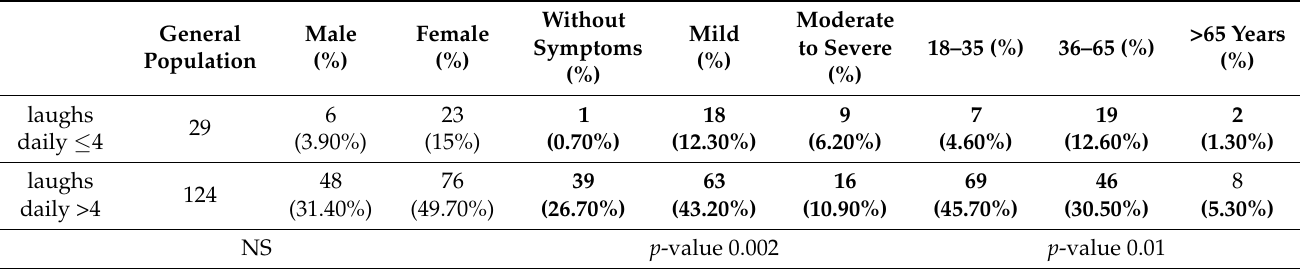
Table 7. Number of laughs per day according to gender, diagnostic severity, and